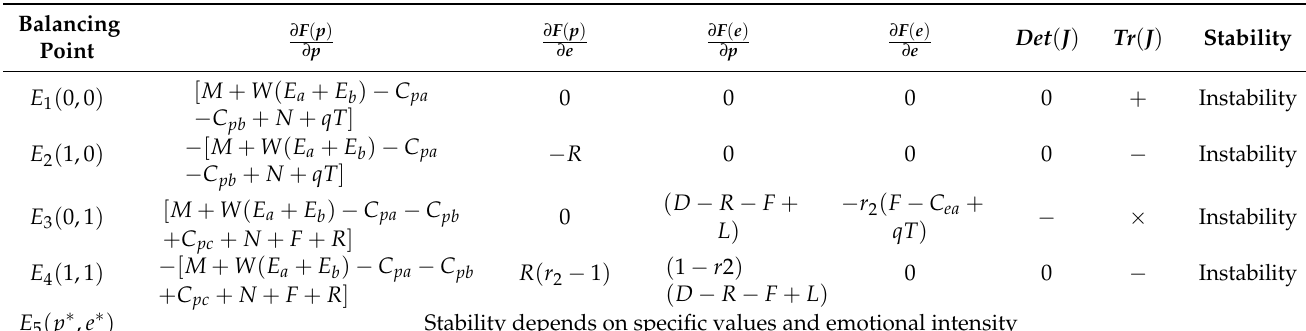
Table 7. Stability analysis of the strategy combination under shared manufacturing supply chain rationality and shared platform emotion scenario.